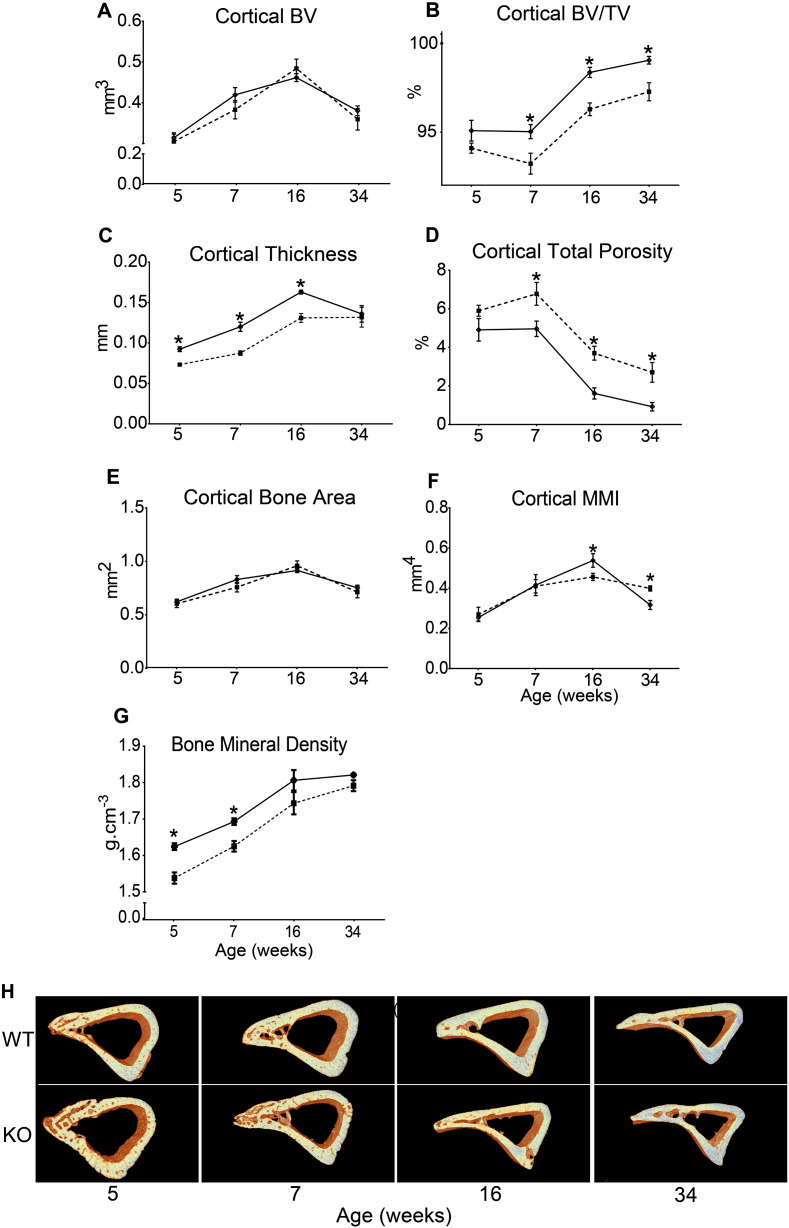
Cortical bone phenotype of WT (solid) and Phospho1 KO (dashed) tibia at 5, 7, 16 and 34 weeks of age. Ex vivo high-resolution analyses of cortical bone at 37% of total tibial length showing (A) cortical total volume (TV), (B) cortical bone volume/total volume (BV/TV), (C) cortical cross sectional thickness, (D) cortical total porosity, (E) cortical degree of anisotropy, (F) cortical mean polar moment of inertia, (G) cortical tissue mineral density and (H) representative 3D μCT images of tibial cortical bone at 37% tibial length in WT and KO mice. Linear graphs represent means ± SEM. Group sizes were n = 6 for 5-, 7- and 16- as well as n = 5 for 34-week old WT and KO mice. Statistical comparisons: p < 0.05 WT and KO of same age.